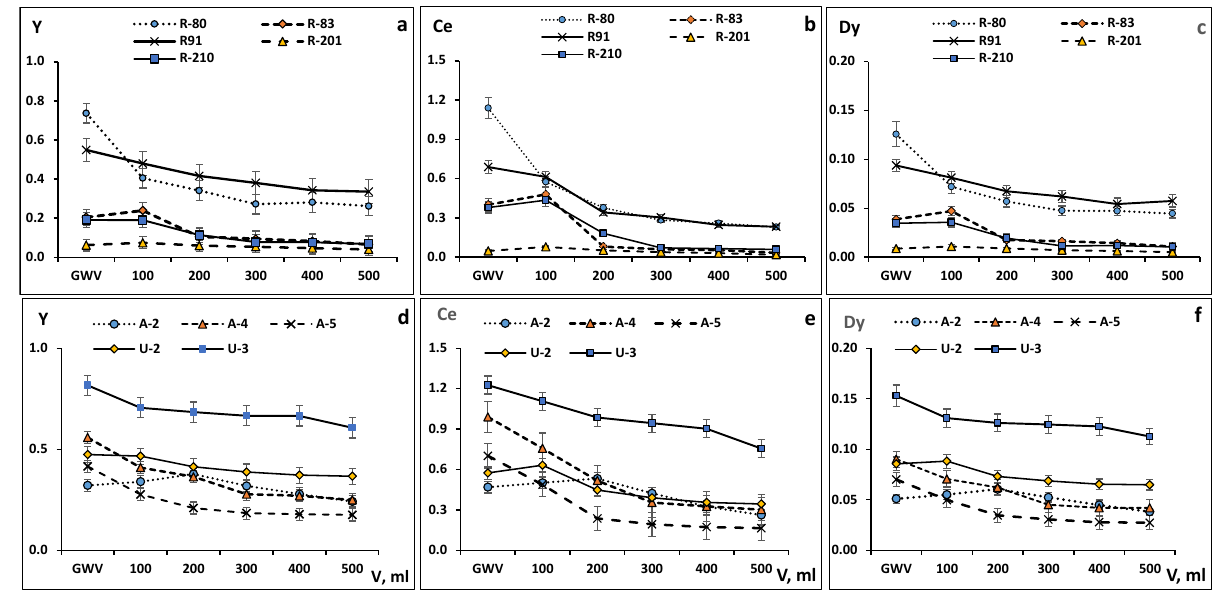
Figure 4. The concentrations of Y ( a , d ), Ce ( b , e ), and Dy ( c , f ) (µg/L) in filtrates obtained at the capsules (GWV) after 500 mL and Millipore membranes after filtration of 100, 200, 300, 400, 500 mL for waters from Razdolnaya R. (upper panel) and Amur R./Ussuri R. (lower panel). The behavior of Mn and Co during clogging of the membrane filters is varied de- pending on the season, initial concentration in the river, and content of suspended solids (Figure 5). At the high initial concentration and low suspended solids in the Razdolnaya R. in winter, dissolved Mn and Co did not respond to the clogging at all (Figure 5a,b). The Amur R. concentration of Mn and Co in winter showed a slight decline, probably due to diminished initial concentrations (Figure 5c). During warm seasons, the decrease in Mn concentration in the filtrates is more gradual compared with Fe and Al or REEs. At the same time, in all our experiments with high suspended solids content, the concentration of Mn in filtrates after 400 mL decreased to 0.4–0.6 µ g/L regardless of variations from 4 to 42 µ g/L after the first 100 mL (Figure 5a). Another dynamic of Mn decrease along with clogging was observed at low suspended solids in the autumn (R-83) when the original high concentration of Mn gradually declined only from 48 to 29 µ g/L after filtering 500 mL sample. In spring (R-210), dissolved Mn decreased from 11 to 6.5 µ g/L at low suspended solids (Figure 5a). A similar in general but less contrasting change of concentration in filtrates along with clogging was observed for Co (Figure